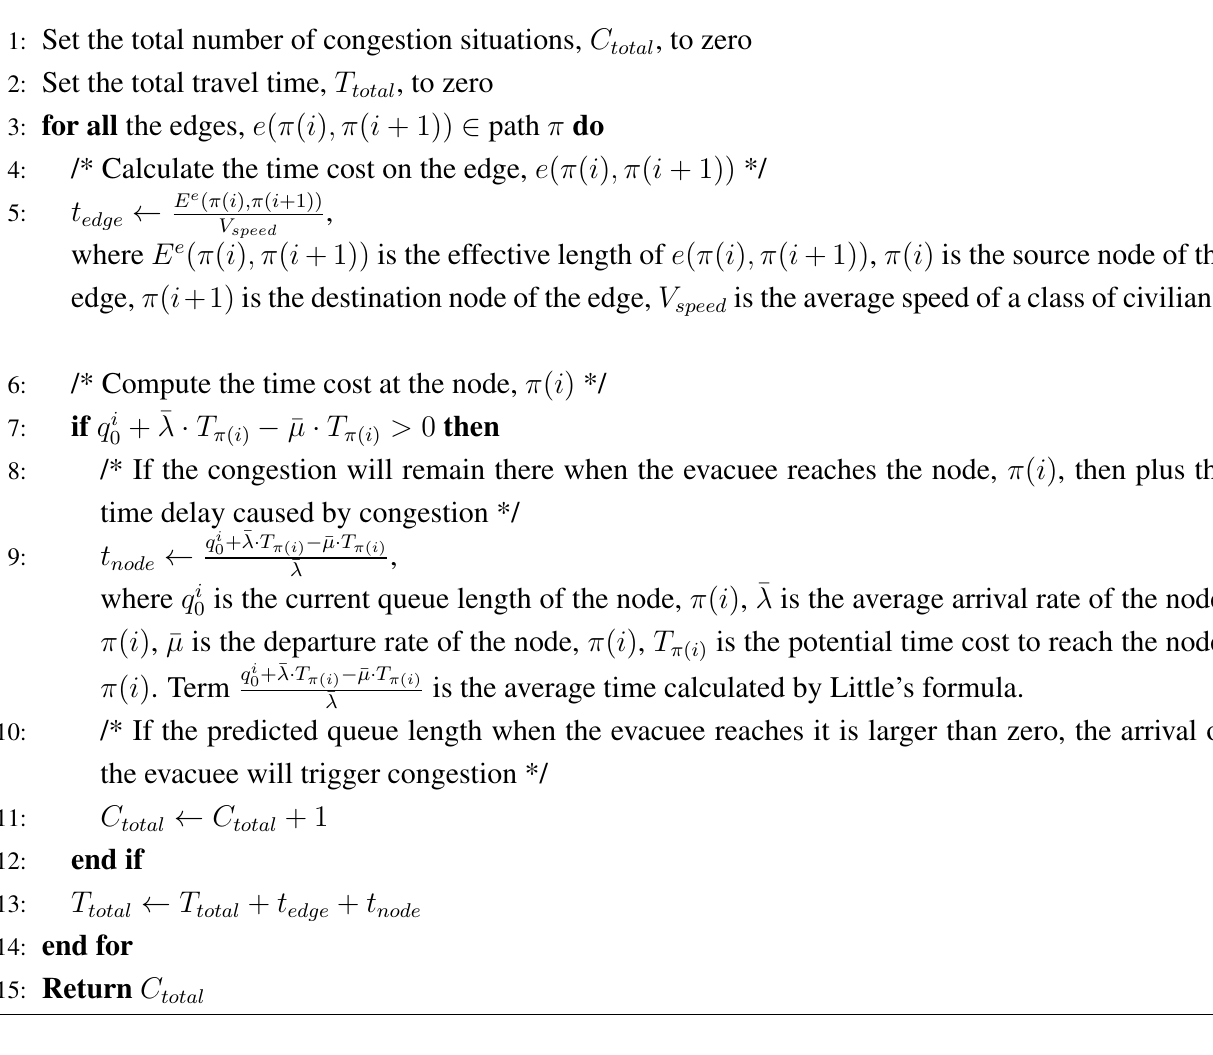
Algorithm 1 Predicting the potential amount of congestion encountered by an evacuee during the evacuation